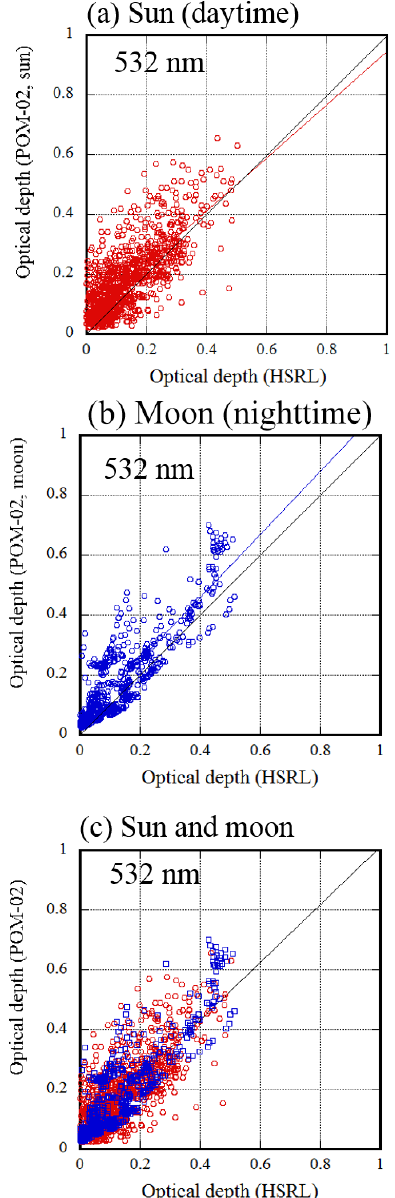
Figure 7. Scatter plot of HSRL and POM-02 aerosol optical depth at 532nm: (a) daytime (red), (b) nighttime (blue), and (c) overlap- ping daytime (red) with nighttime (blue).